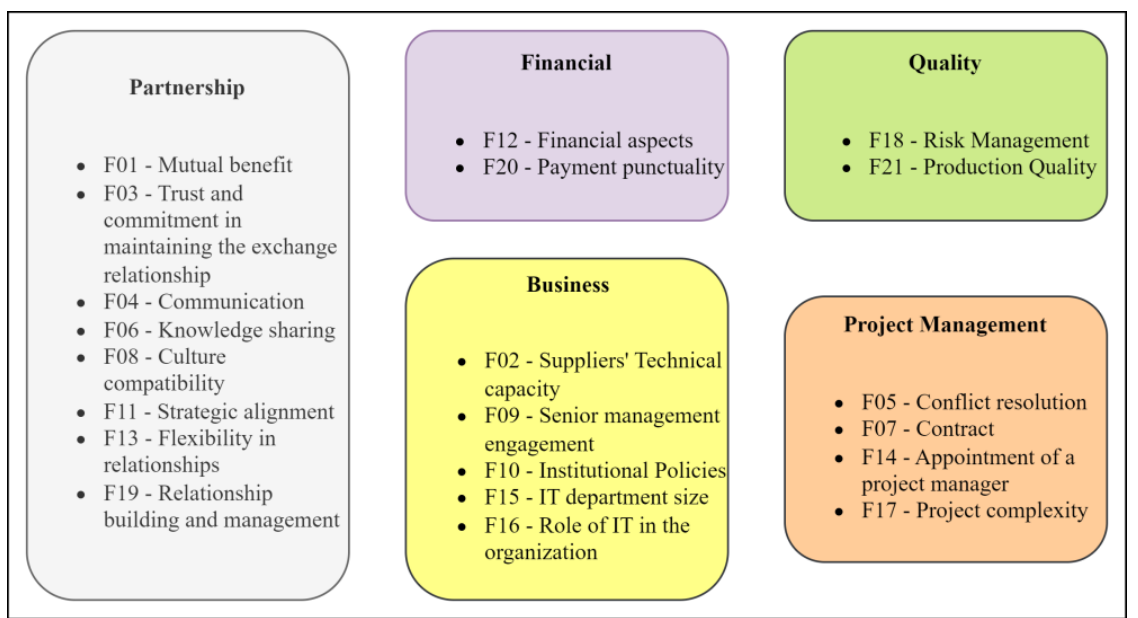
Figure 3. Grouping by conceptual affinities of key